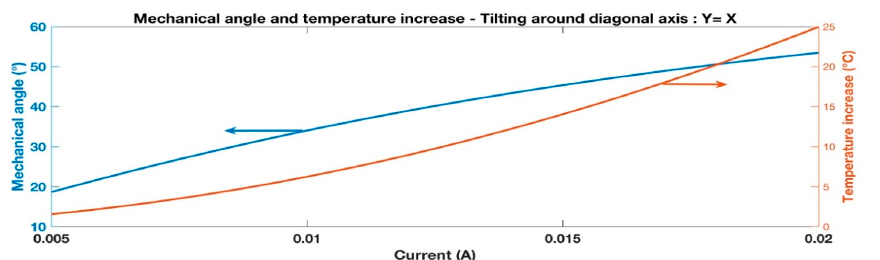
Figure 2. Results of simulated micro-mirror when tilting around diagonal axis of ϕ ( y = x ).